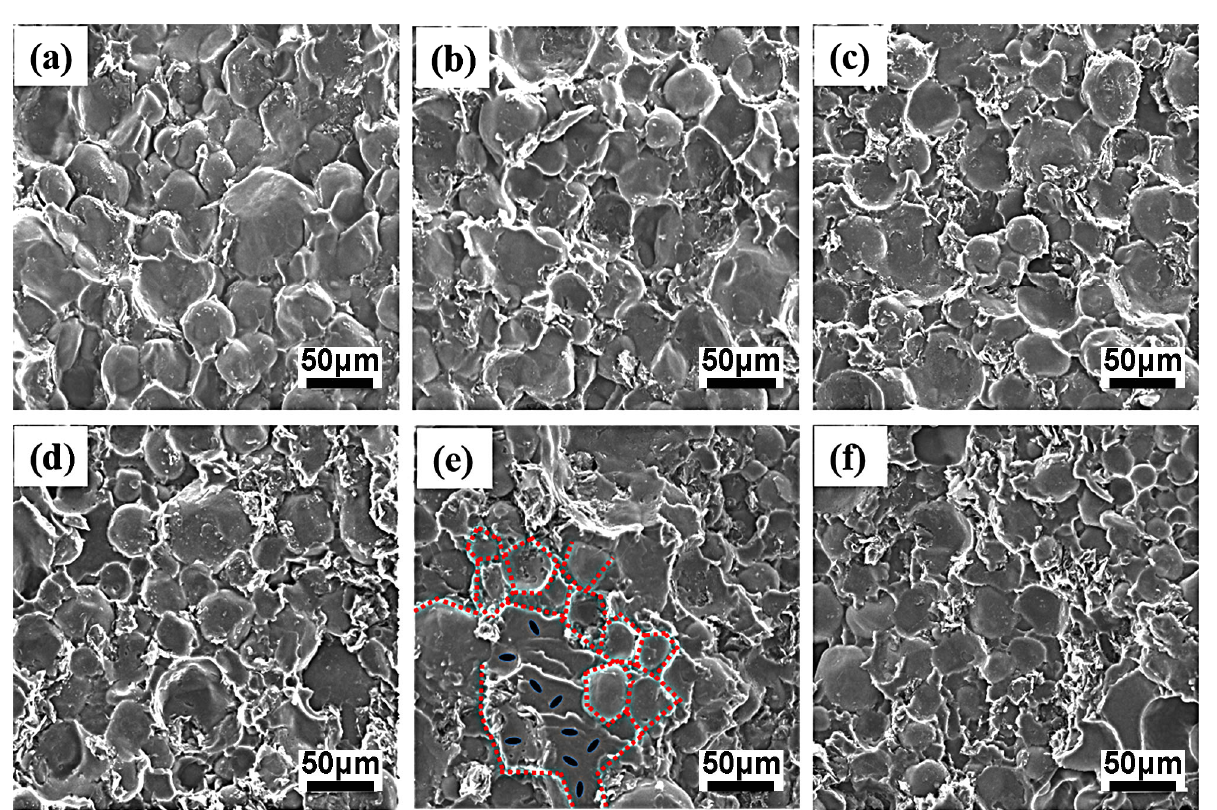
Figure 6. SEM images of 80PA6/20PA612-GS composites of different GS contents: 0 wt% ( a ), 1 wt% ( b ), 3 wt% ( c ), 5 wt% ( d ), 7 wt% ( e ), and 9 wt% ( f ).